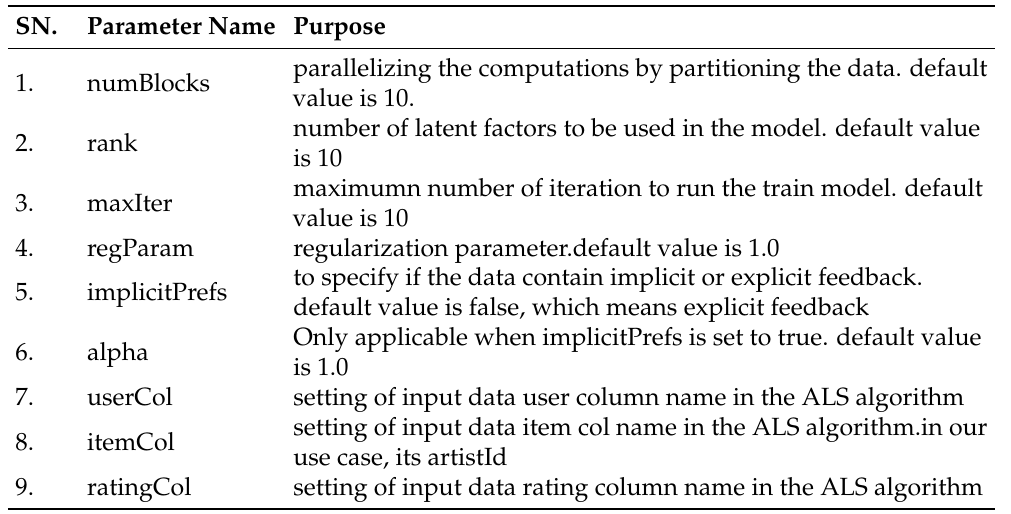
Table 2. Supported graphical ML components with their